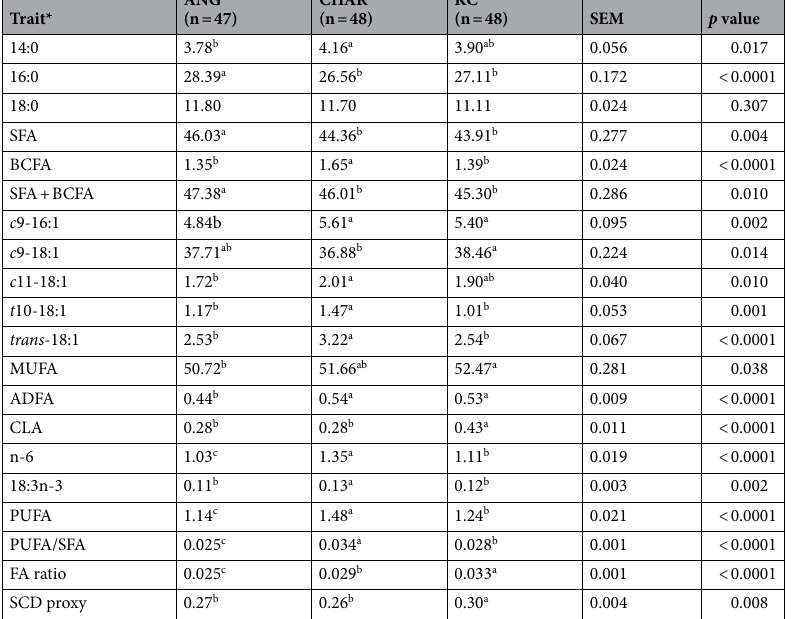
Table 2. Effects of different breeds on fatty acid proportion (%) in subcutaneous tissues of beef cattle. *The concentrations of fatty acids were expressed as a percentage of fatty acid methyl esters (FAME) quantified. Significant effects ( p < 0.05) of breed on fatty acid are presented. c = cis ; t = trans ; SFA (sum of saturated fatty acid) = 10:0 + 12:0 + 14:0 + 15:0 + 16:0 + 17:0 + 18:0 + 19:0 + 20:0; BCFA (sum of branched chain fatty acid) = iso −14:0 + iso -15:0 + anteiso -15:0 + iso -16:0 + iso -17:0 + anteiso -17:0 + iso -18:0; SFA + BCFA = sum of SFA and BCFA; trans- 18:1 (sum of trans- 18:1) = t 6-18:1 + t 9-18:1 + t 10-18:1 + t